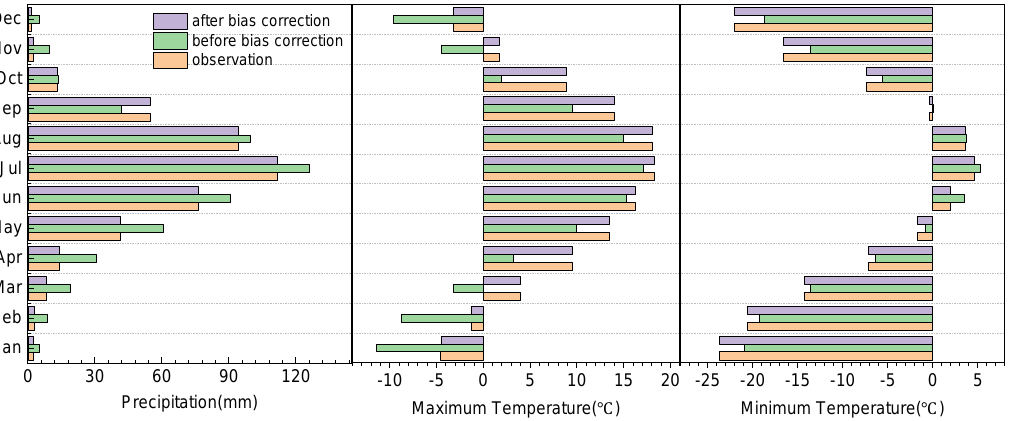
Figure 3. Interannual distribution of meteorological data before and after bias correction and historical observations.